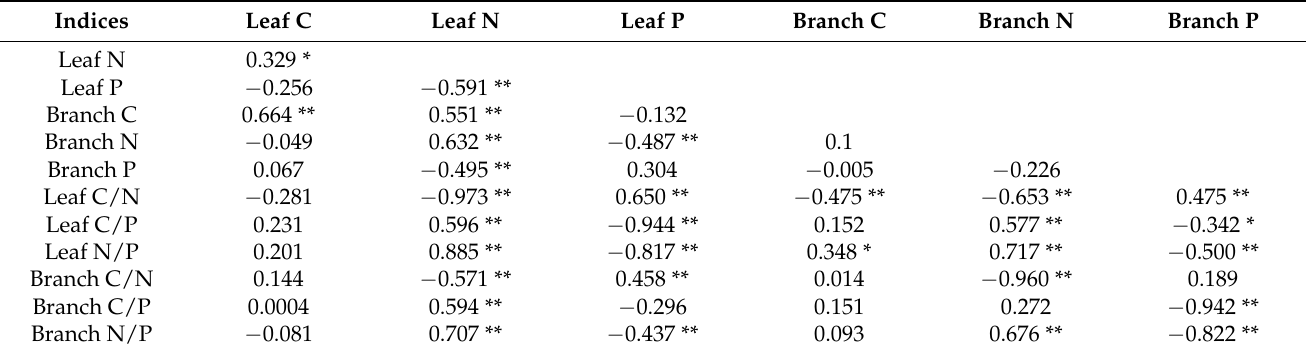
Table 3. The correlation of C, N and P contents and their ratios of different organs of male plants of F. velutina